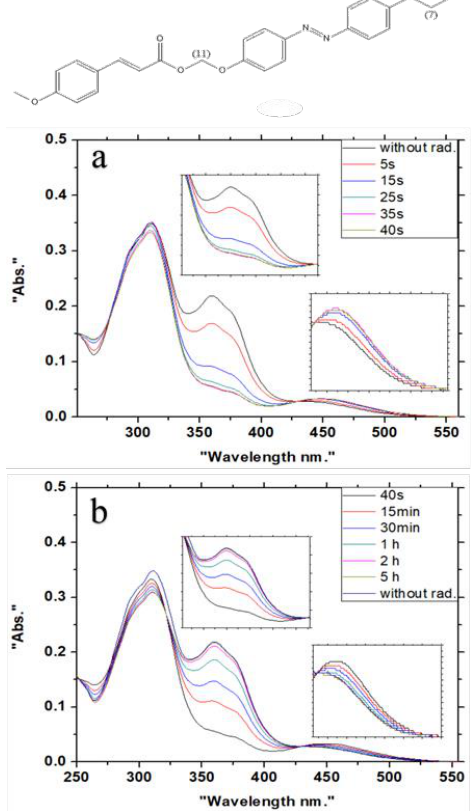
Figure 3. UV spectra of 1b : ( a ) during irradiation at λ = 350 nm (photochemical trans – cis isomerization of the azobenzene moiety), ( b ) thermal cis – trans isomerization of the azobenzene moiety.